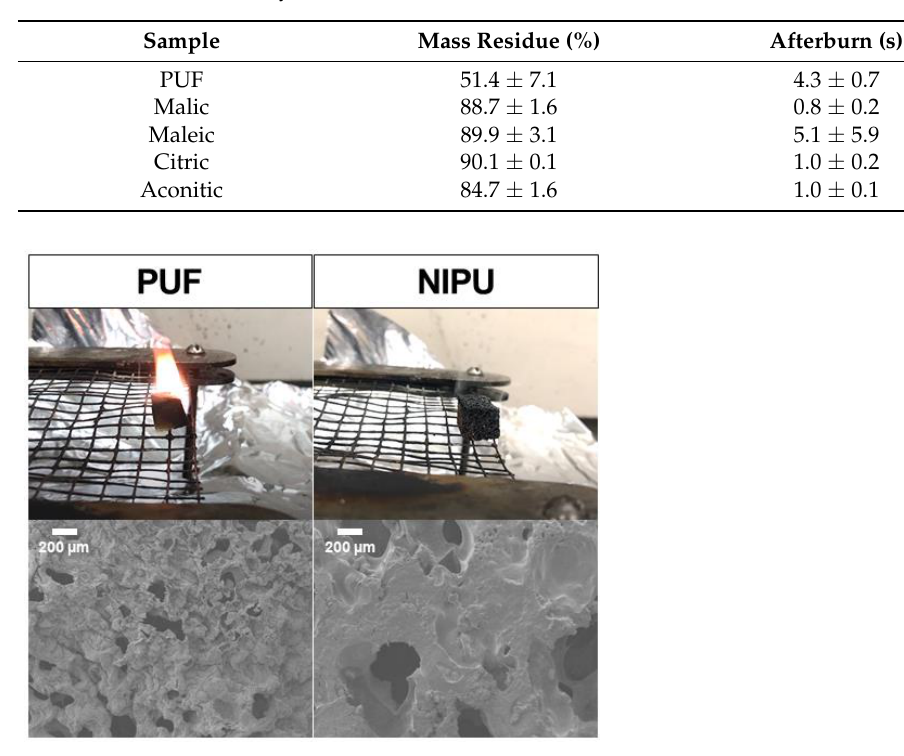
Table 3. Foam flammability results from 10 s butane torch test.